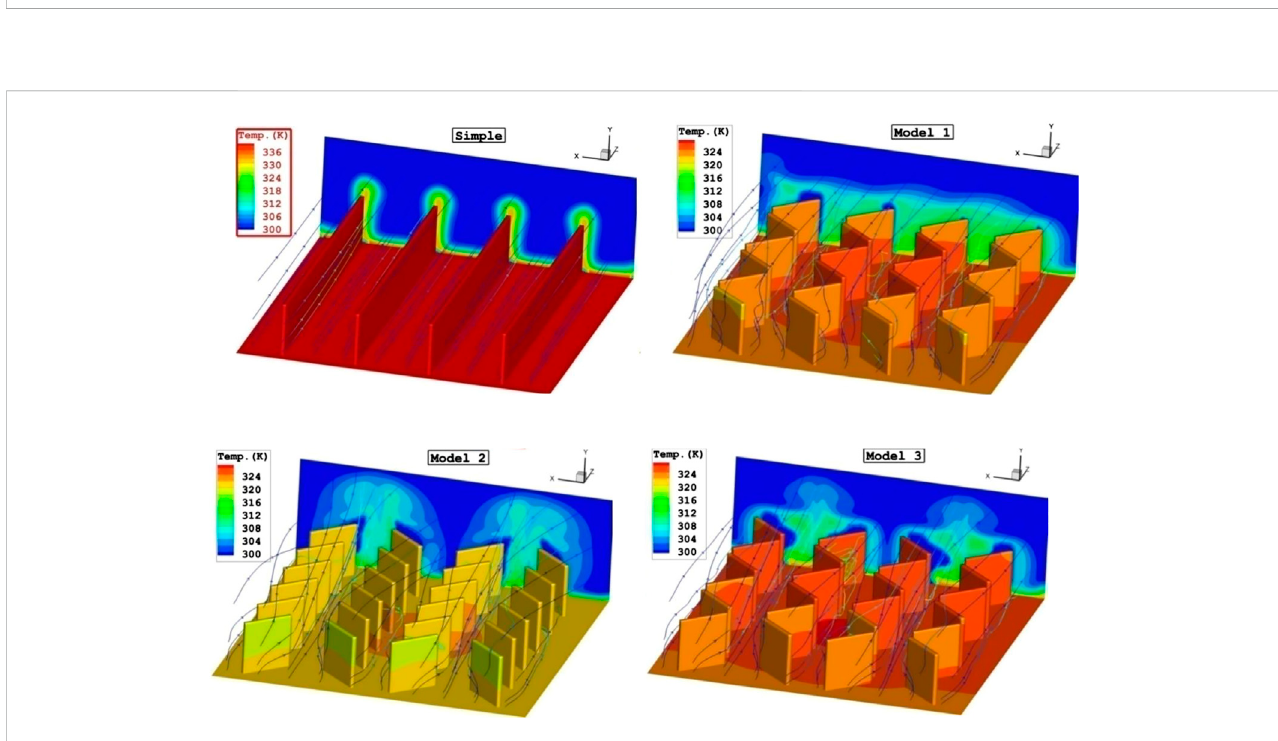
FIGURE 4 Comparisons of temperature distribution for various fi n arrangements on the base plate with limited heat fl ux (Park et al., 2015).